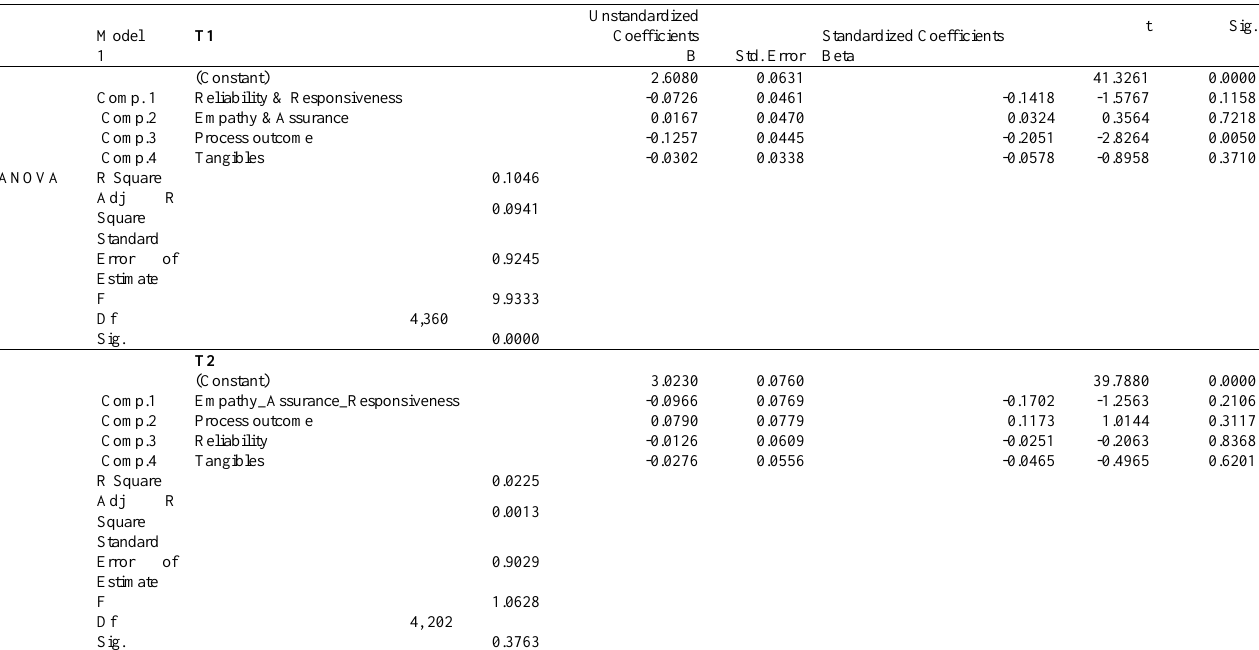
Table 5: Multiple regression coefficients times T1 and T2